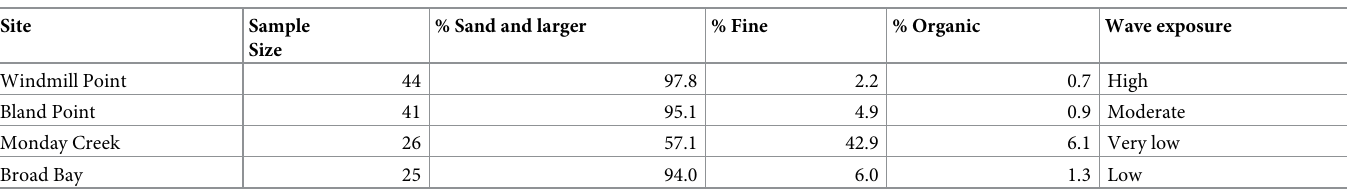
Table 3. Site characterization of sediment bed